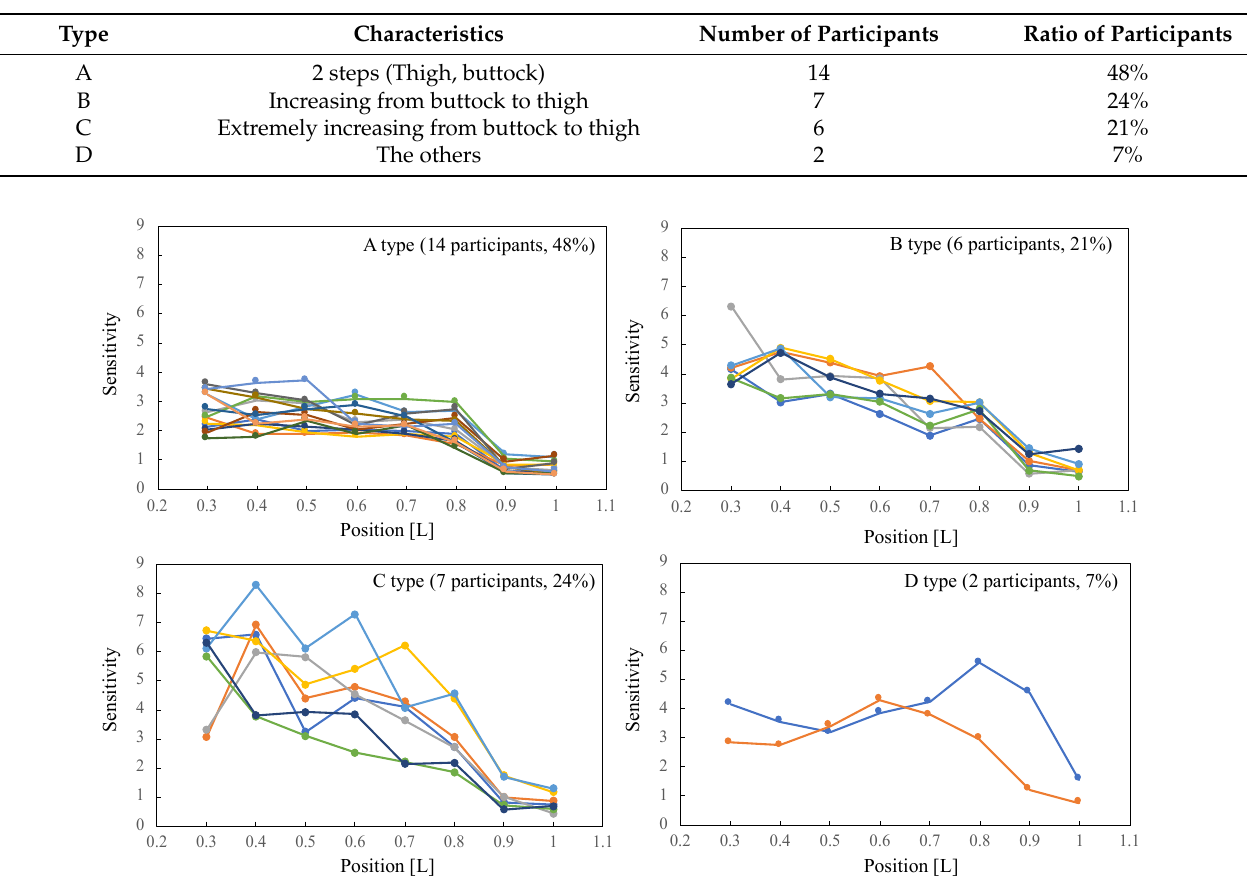
Table 2. Types of sensitivity.